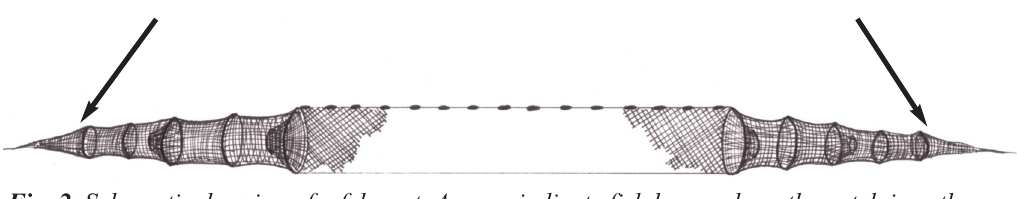
Fig. 2. Schematic drawing of a fyke net. Arrows indicate fish bags, where the catch is gath-